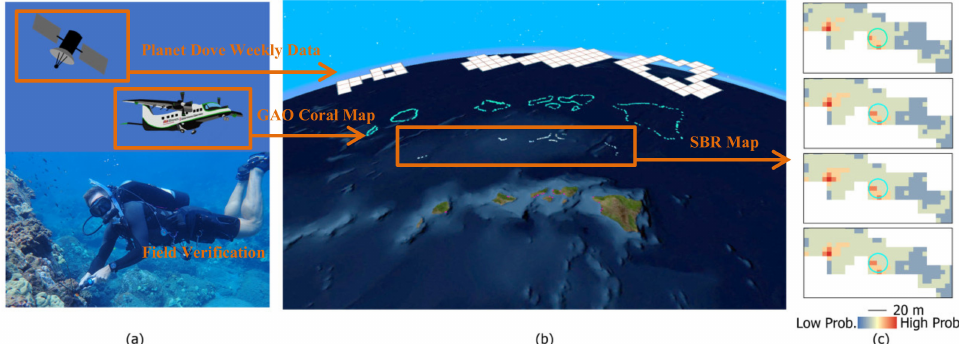
Figure 1. General methodology for bleaching detection. ( a ) Techniques used for coral bleaching detection. ( b ) We used a combination of Planet Dove satellite time series data for coral regions defined from a